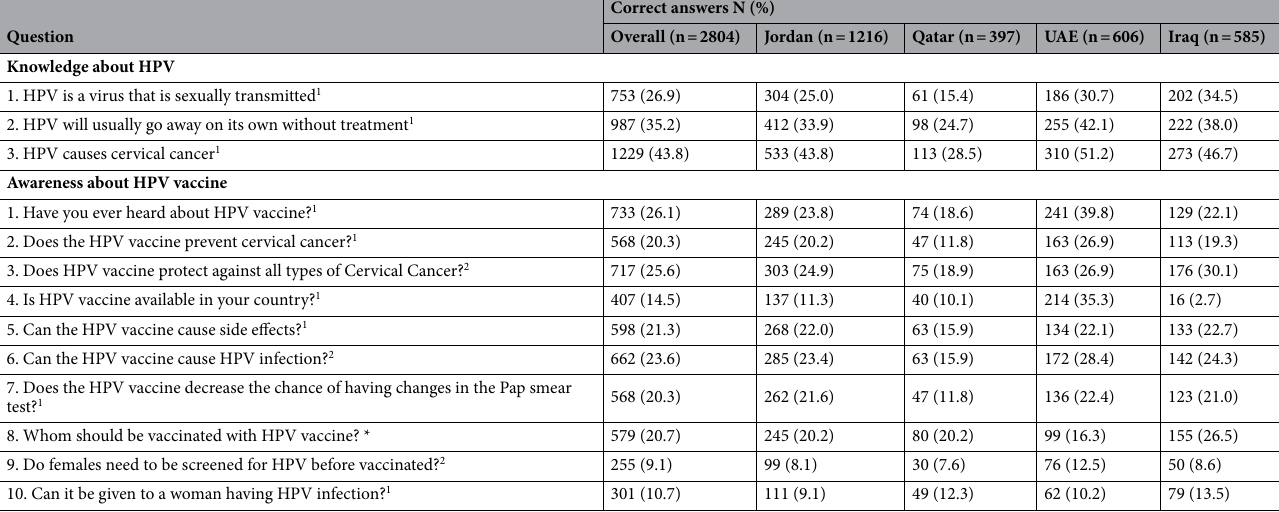
Table 2. Participant’s knowledge about Human Papilloma Virus and awareness about vaccine (n = 2804). 1: Yes, 2: No, *: Males and females.